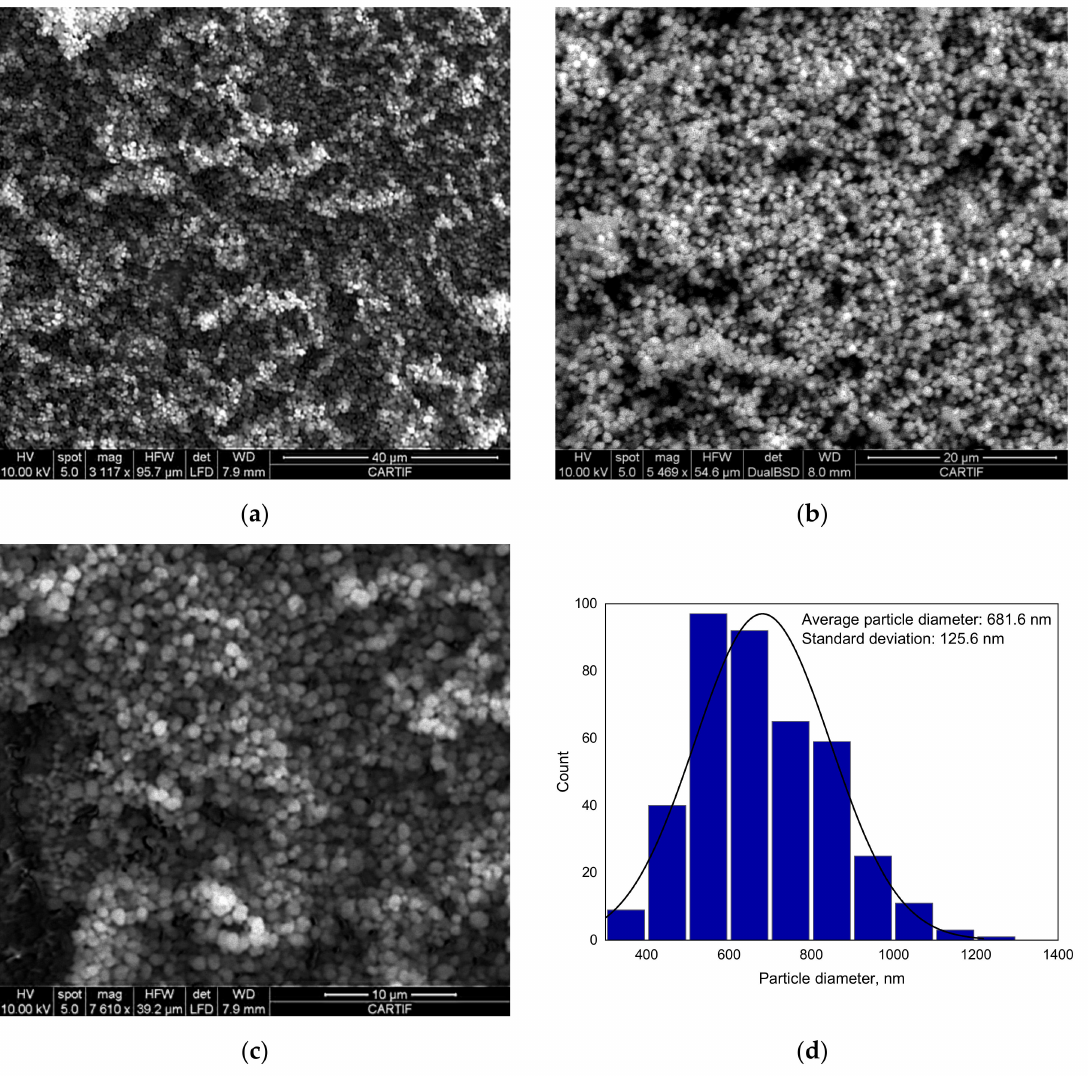
Figure 4. Scanning electron microscopy (SEM) micrographs at different magnifications of the as-synthetized Ni–Fe–Cu/LDH at different horizontal field widths (HFWs): ( a ) 95.7 µ m, ( b ) 54.6 µ m, ( c ) 39.2 µ m, and ( d )